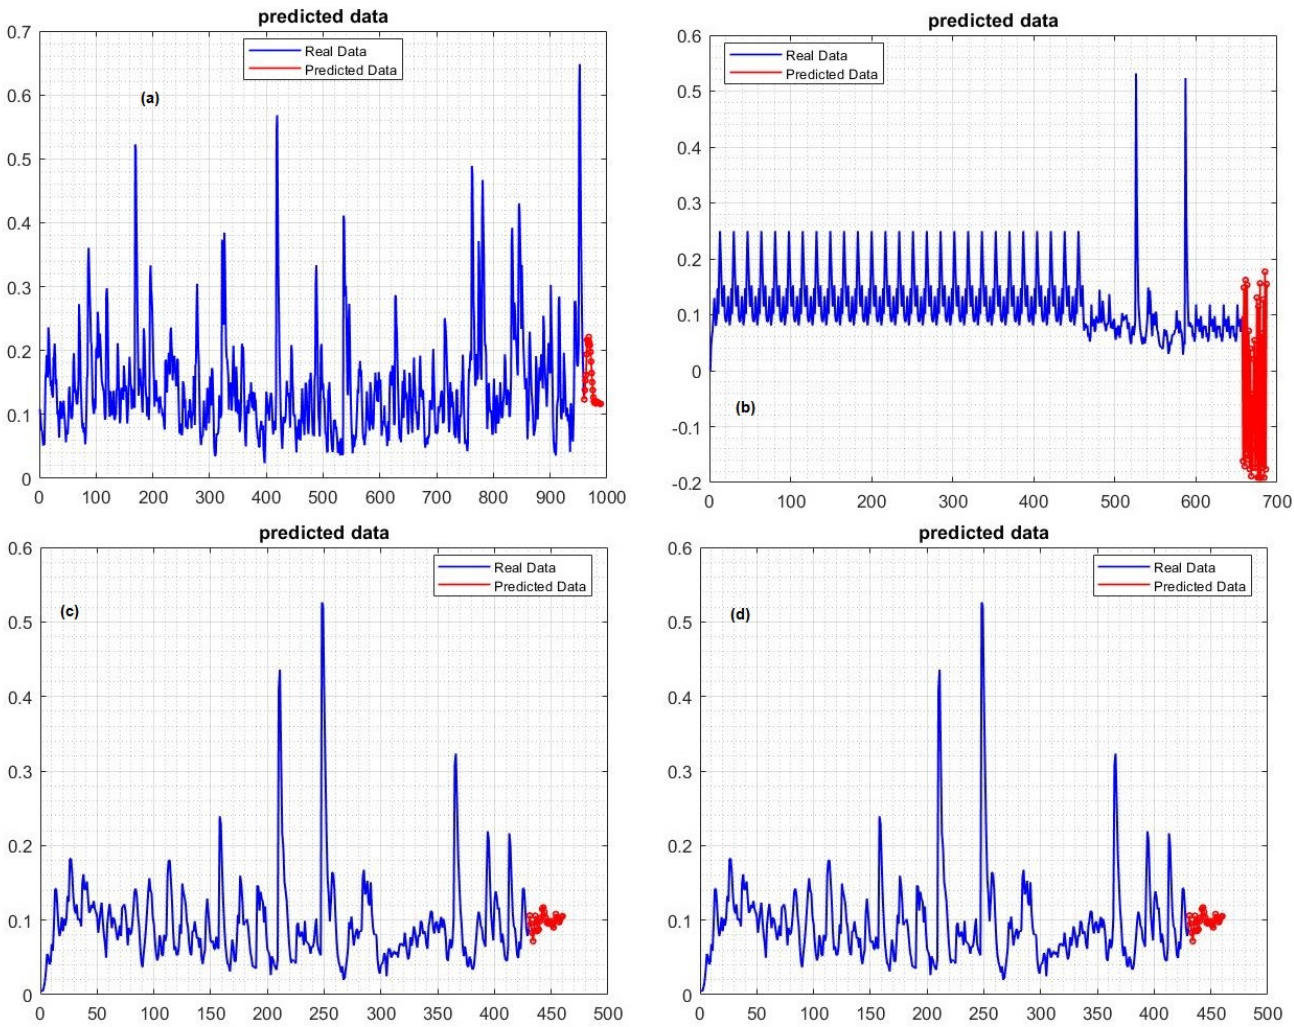
Figure 6. Values forecasted using the ANN model: ( a ) Riyadh, ( b ) Dammam, ( c ) Jeddah, and ( d ) Al-Khobar.